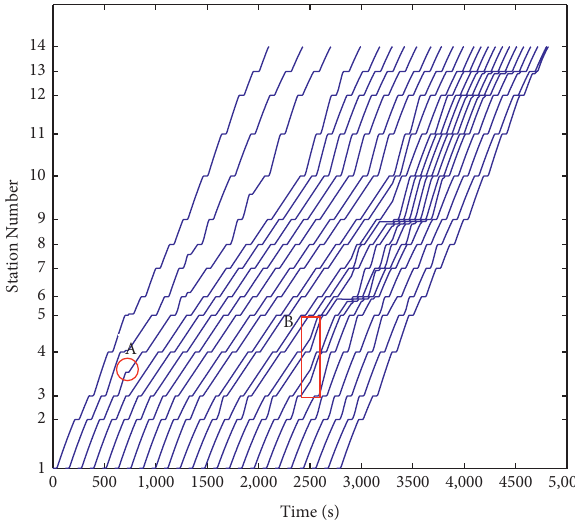
Figure 7: Practical timetable under scenario